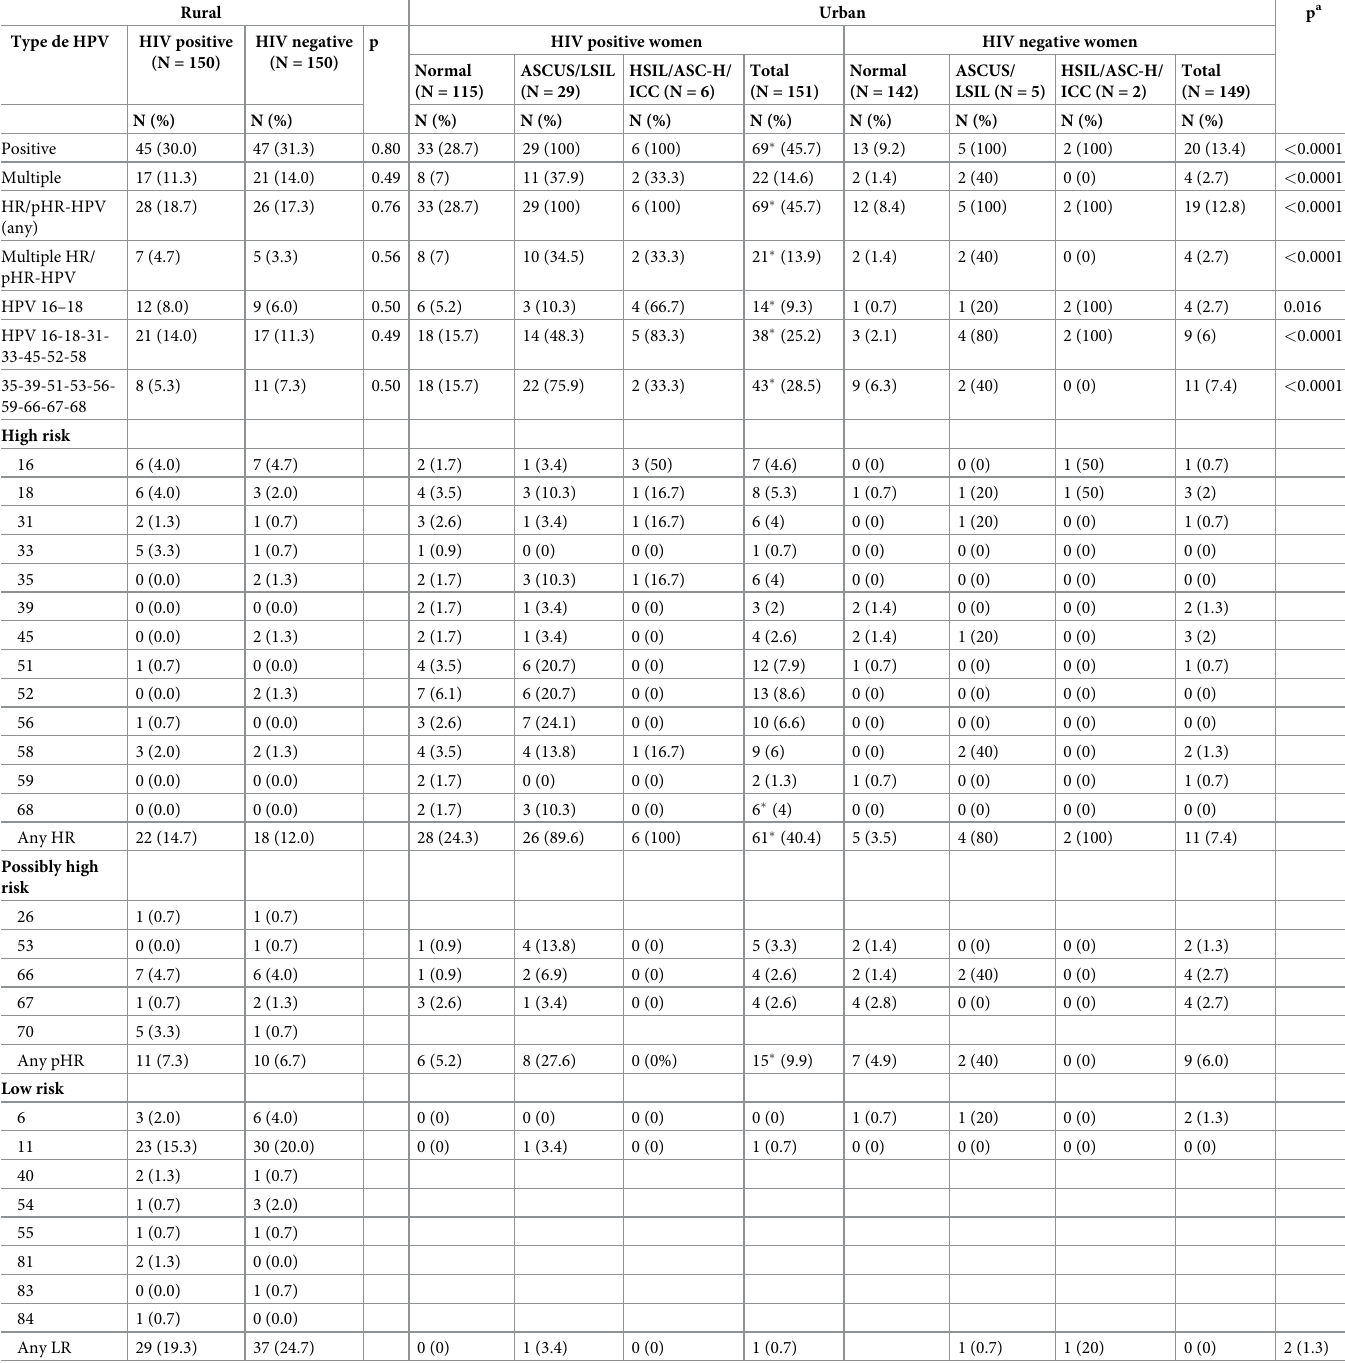
Table 2. Prevalence of human papillomavirus by HIV status in rural and urban areas among 600 women in Burundi. Rural Urban p